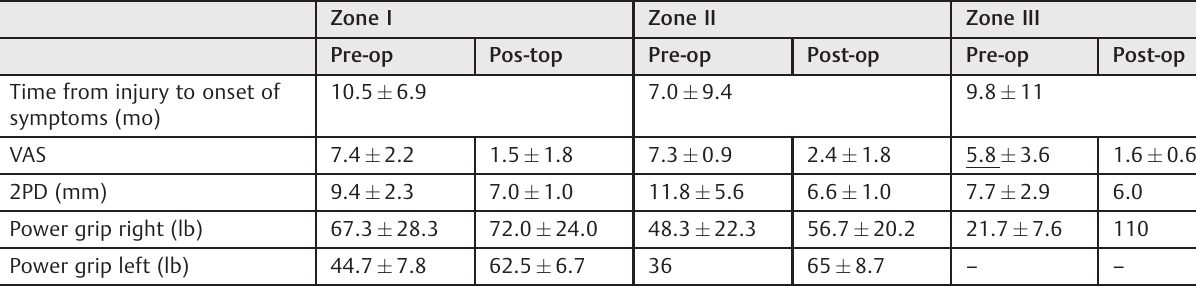
Table 2 Results according to the site of neuroma